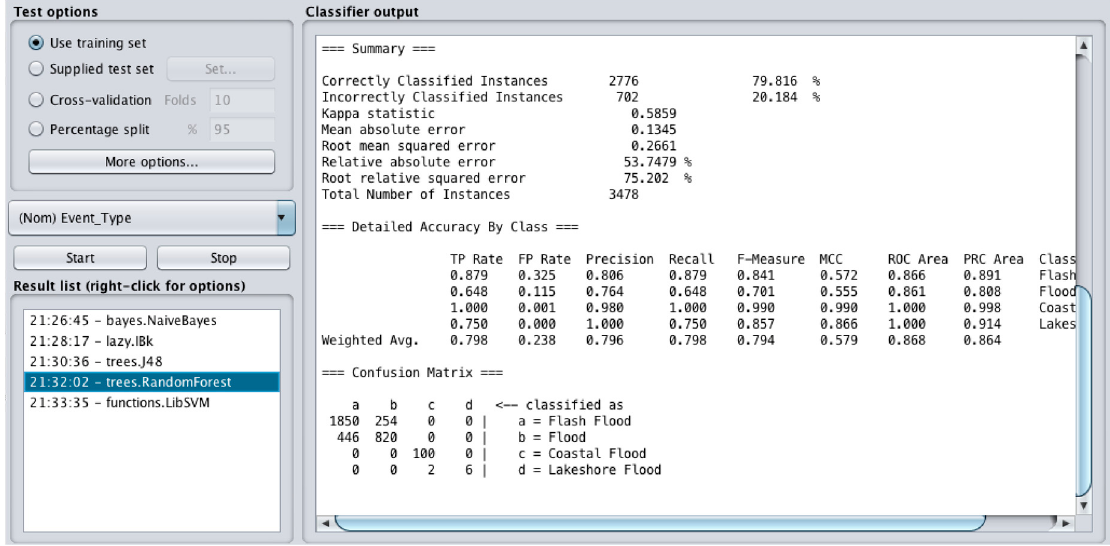
Figure 6. Evaluation Results for Random Forest model in Weka.